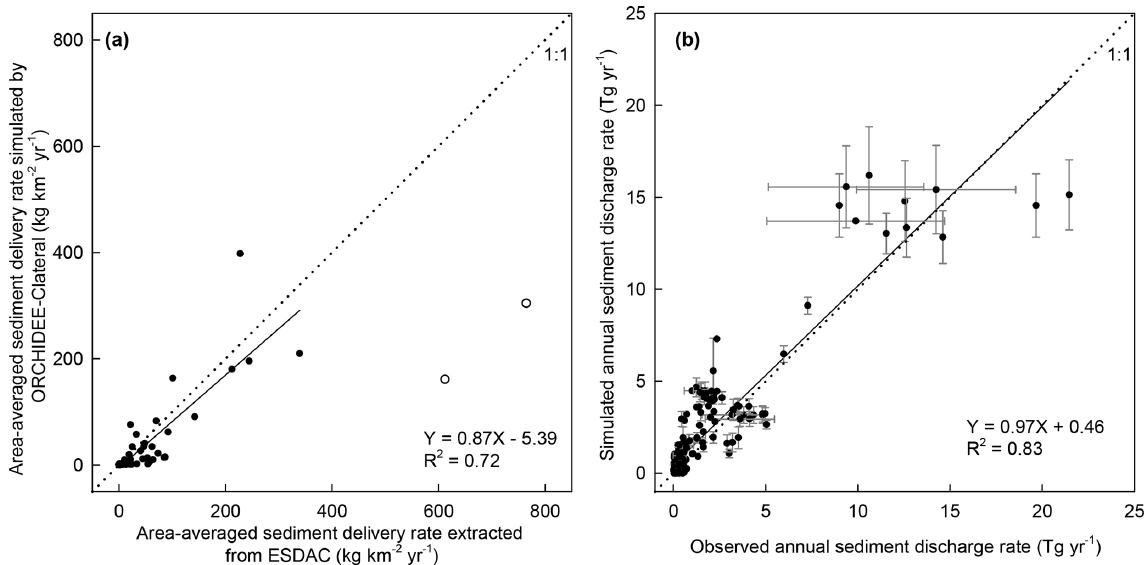
Figure 4. Comparison between the simulated area-averaged sediment delivery rate from uplands to the river network from ORCHIDEE- C lateral and WaTEM/SEDEM (a) , as well as the comparison between observed and simulated annual sediment discharge rates at 221 gauging sites (b) . In panel (a) , the two hollow dots represent the sediment delivery rates at the two catchments in the Apennine Peninsula (Fig. S3d). The regression function in panel (a) was obtained based on the values of all solid dots, excluding the two hollow dots. In panel (b) , the error bar denotes the standard deviation of interannual variation. Sources of the observed annual sediment discharge rate are in Table